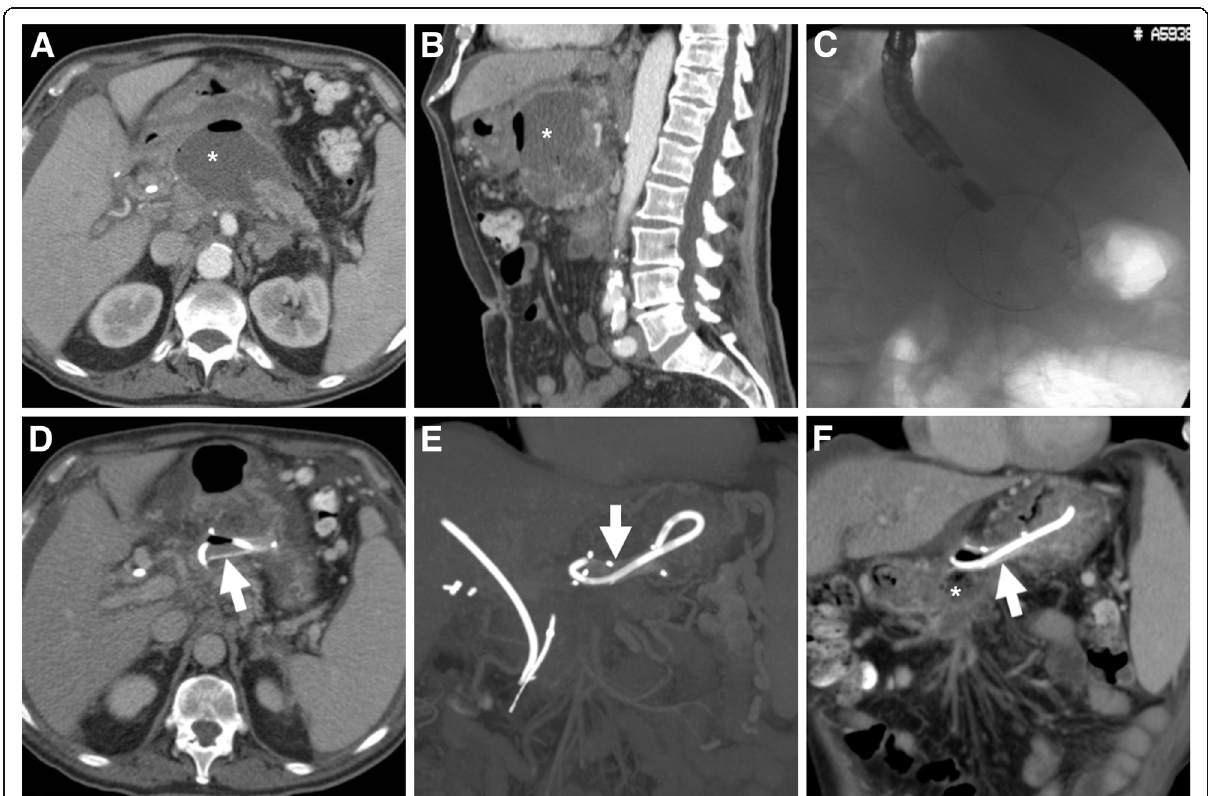
Fig. 4 In a 67-year-old male with history of AP, following ineffective trans-duodenal drainage and stent loss, MDCT ( a , b ) showed reappearance of a fluid-containing collection (*) in the lesser sac with some nondependent air, suspicious for superinfected WOPN. Note biliary stent in place. Transferred to our hospital, endoscopic retreatment included cystogastrostomy and necrosectomy ( c ) with positioning of a plastic pigtail through the metal stent (thick arrows) in follow-up MDCT ( d , e ), a MPD stent (in maximum-intensity projection MIP E) and achieved rapid decrease of the collection. Ultimately, the metal stent was lost and the distal tip of the pigtail fell outside the incompletely collapsed collection (* in f